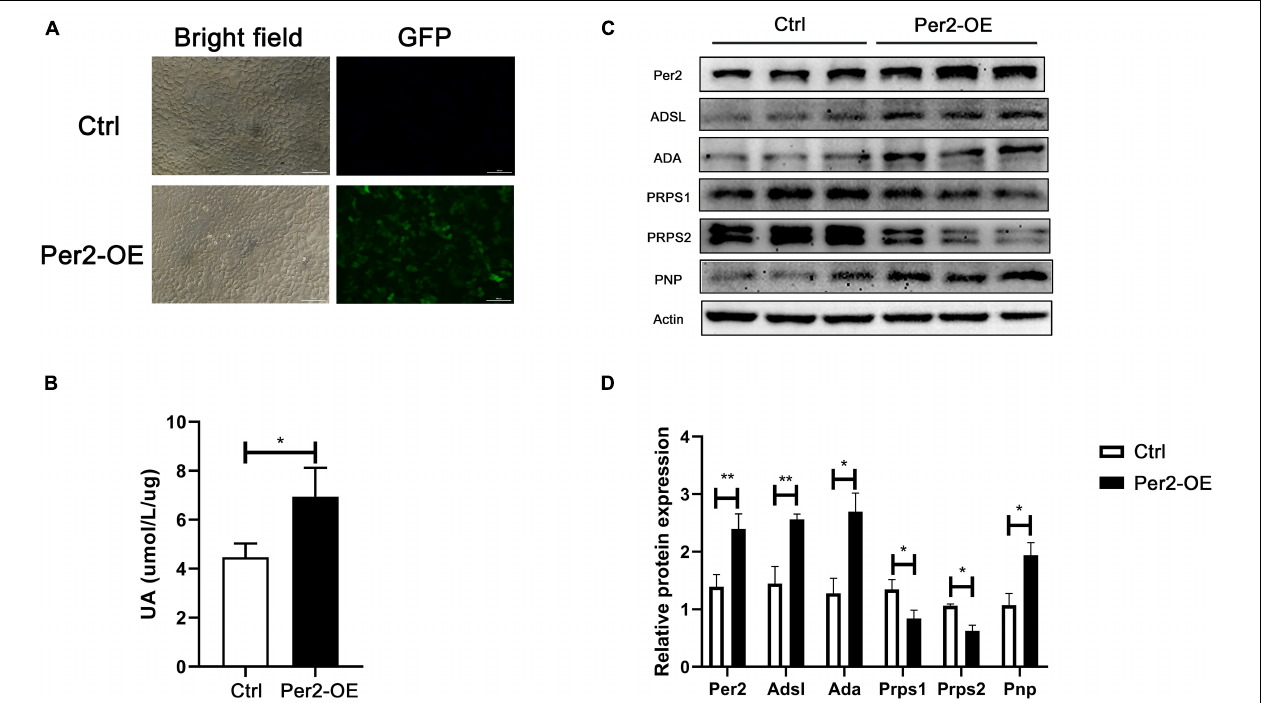
FIGURE 4 | (A) Detection of GFP by fluorescence microscopy at 48 h after transfection (Per2-OE, Per2 overexpressing cells). (B) Urate production in cell culture supernatant at 72 h after transfection. (C) Protein expression after Per2 overexpressing in cells. (D) ImageJ (NIH) semiquantitative analysis of the levels of multiple enzymes involved in nucleotide metabolism (* P < 0.05; ** P <